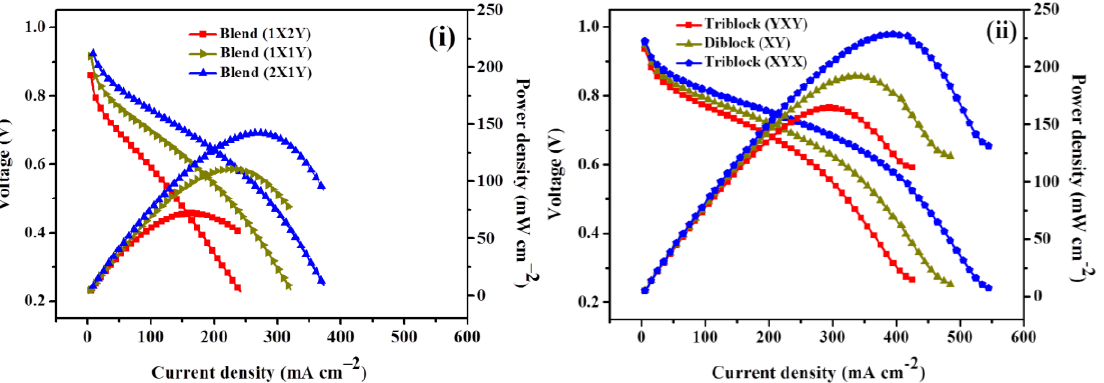
Figure 10. H 2 /O 2 PEFC curves of ( i ) blend and ( ii ) block copolymer membranes evaluated at 60 °C under 60% RH. Table 3. Comparison table of performance of various block copolymer PEMs